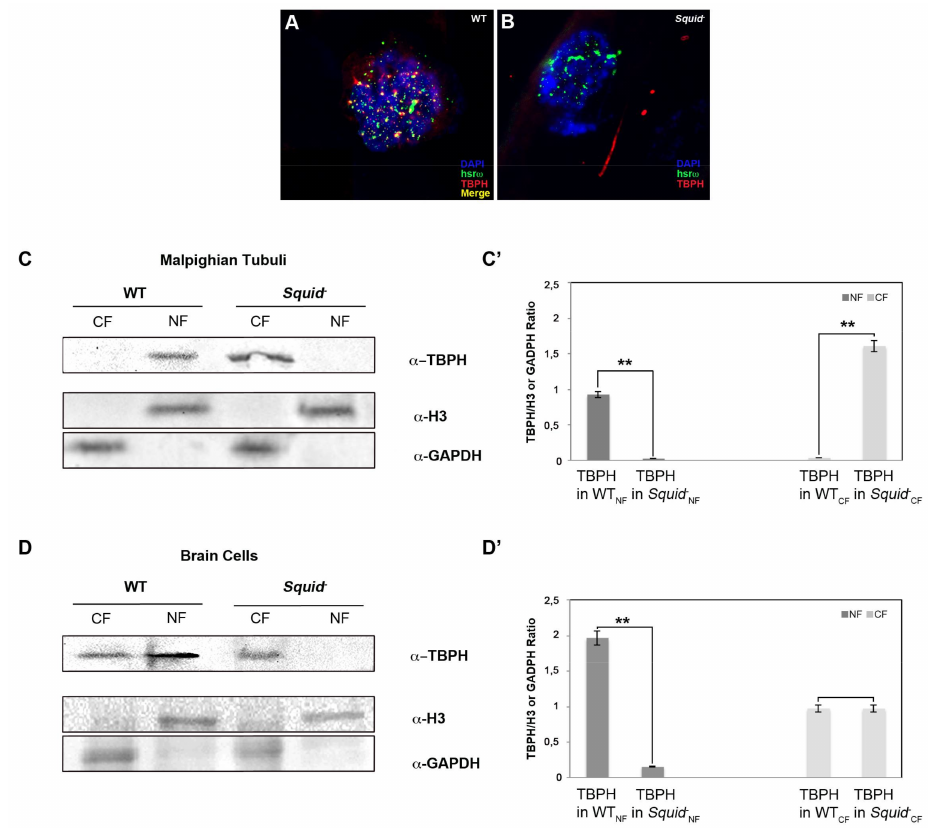
Figure 6. Loss of Squid causes severe changes in TBPH localization. ( A , B ) Compared to WT ( A ), loss of Squid changes TBPH protein (red) distribution between nucleus and cytoplasm in MT of Squid - null mutants ( B , C ). Indeed, TBPH loses its co-localization with hsr ω (green) and it is predominantly distributed in the cytoplasm (Red arrows). ( C , D ) Western blots confirming the data for MT cells ( C ) as well as BCs ( D ). ( C’ , D’ ) The intensity of Western blot signals was quantified using ImageJ. The experiment was performed considering five biological replicates. The error bars show the standard deviation. Unpaired Student’s t -test was performed to assay statistical significance; * 0.01 ≤ p -value ≤ 0.05; ** p -value <